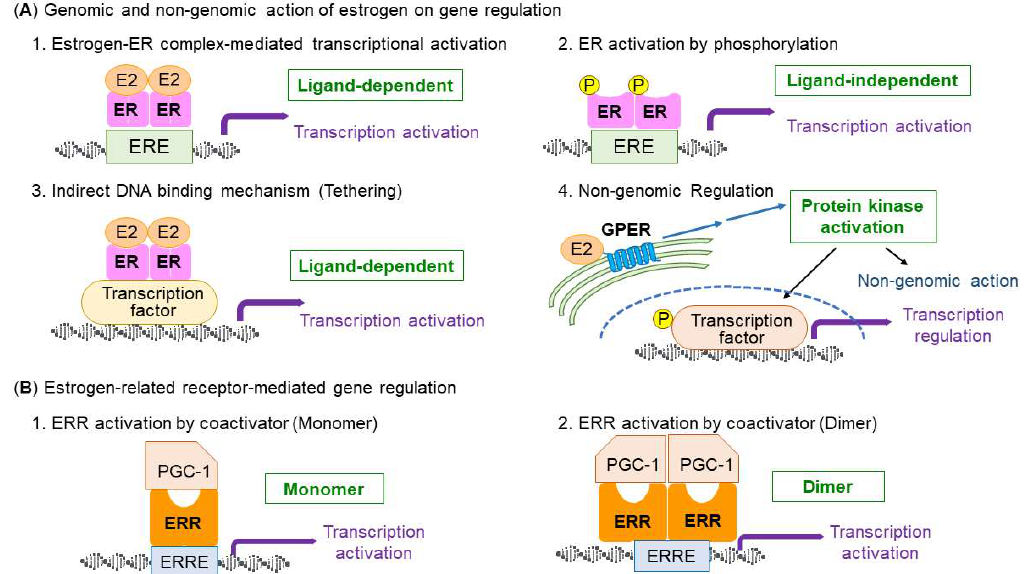
Figure 1. Classical nuclear estrogen receptors (ERs) and membrane-type G protein-coupled estrogen receptor (GPER). ( A ) Endogenous estrogens, including 17 β -estradiol (E2), bind to two types of nuclear ERs (i.e., ER α , ER β ) or membrane-type GPER, which is predominately localized to the intracellular membranes. Estrogen activates nuclear ERs, inducing the dimerization of the receptors and binding of receptors to estrogen responsive elements (EREs) in the genome. Alternatively, ERs bind with other classes of transcription factors through protein–protein interactions and the complexes bind to the genome. GPER stimulates the activation of protein kinases (i.e., MAPK and PI3K/Akt), which mediates nongenomic actions of estrogen and contributes to transcription factor regulation [43]. ( B ) Schematic model for transcriptional regulation by ERRs and its coactivator PGC-1. ERRs preferentially bind to estrogen-related receptor responsive elements (ERREs) in the genome as a monomer or a dimer. PGC-1 is a necessary coactivator for the activation of ERR transcription activity.